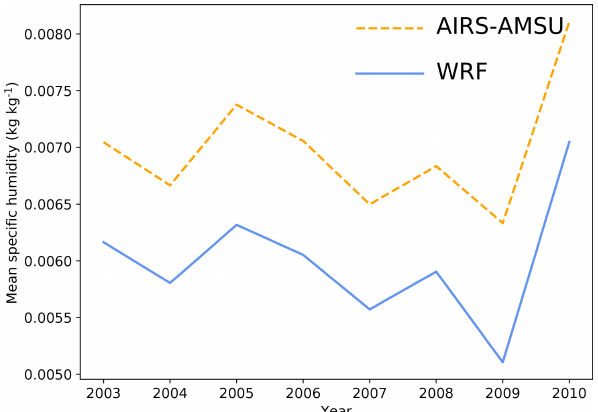
Figure 7. May–September mean specific humidity at 2m from WRF (solid blue line) and AIRS–AMSU surface humidity (dashed orange line) for a 1 ◦ × 1 ◦ bin around 38.5 ◦ N, 77.5 ◦ E, which is an irrigated area in the Tarim that contributes to the snowfall in the